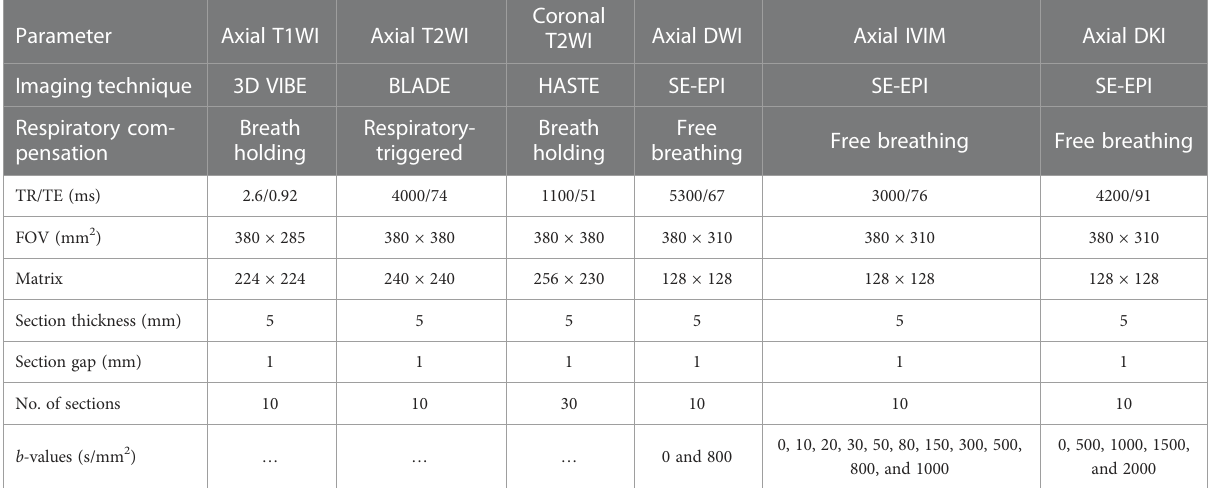
TABLE 1 MR imaging